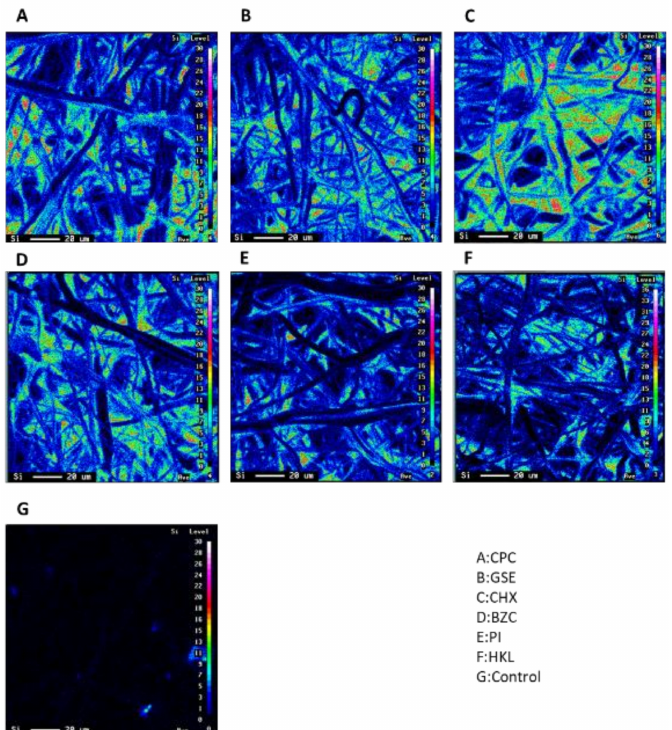
Figure 2. Elemental mapping of the fiber surfaces of non-woven fabric filters treated with CPC ( A ), GSE ( B ), CHX ( C ), BZC ( D ), PI ( E ), or HKL ( F ). The presence of Si on the fibers of non-woven fabric filters was confirmed in ( A – F ), but not in ( G ) (Control).